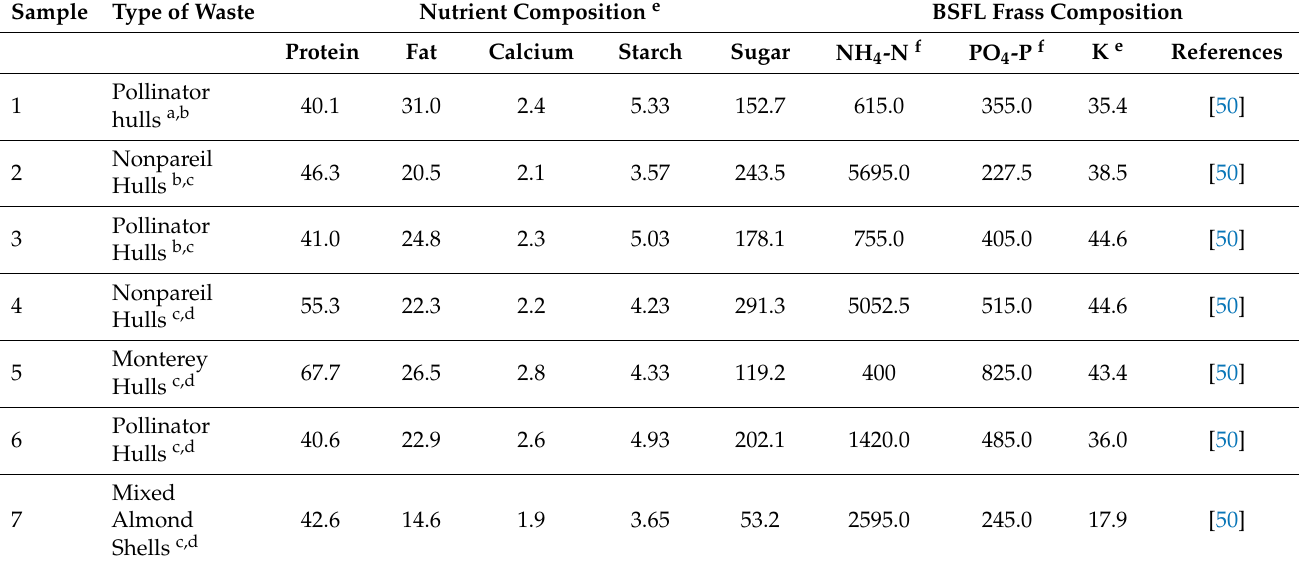
Table 3. The composition of food waste attribute to BSFL frass